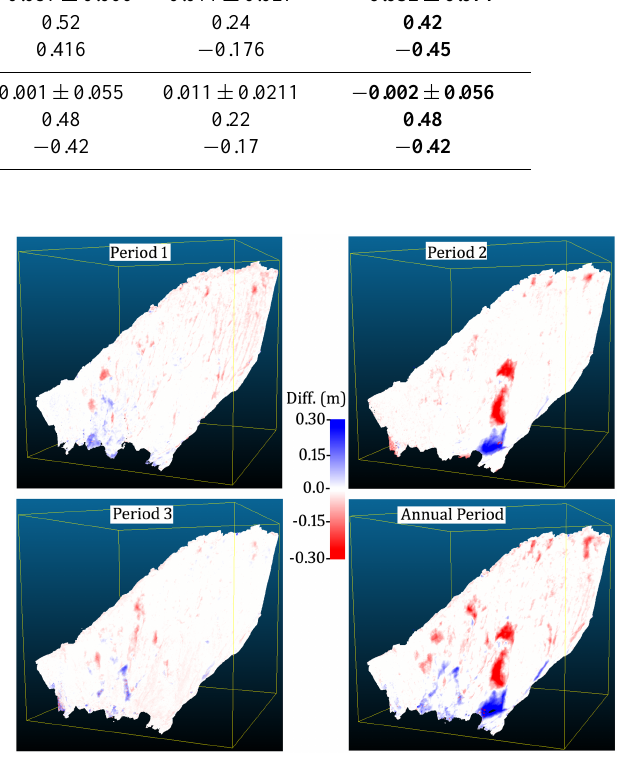
Figure 7. Topographic changes observed at the monitoring inter- vals and at annual scale obtained with TLS on south-facing slopes (CloudCompare software).